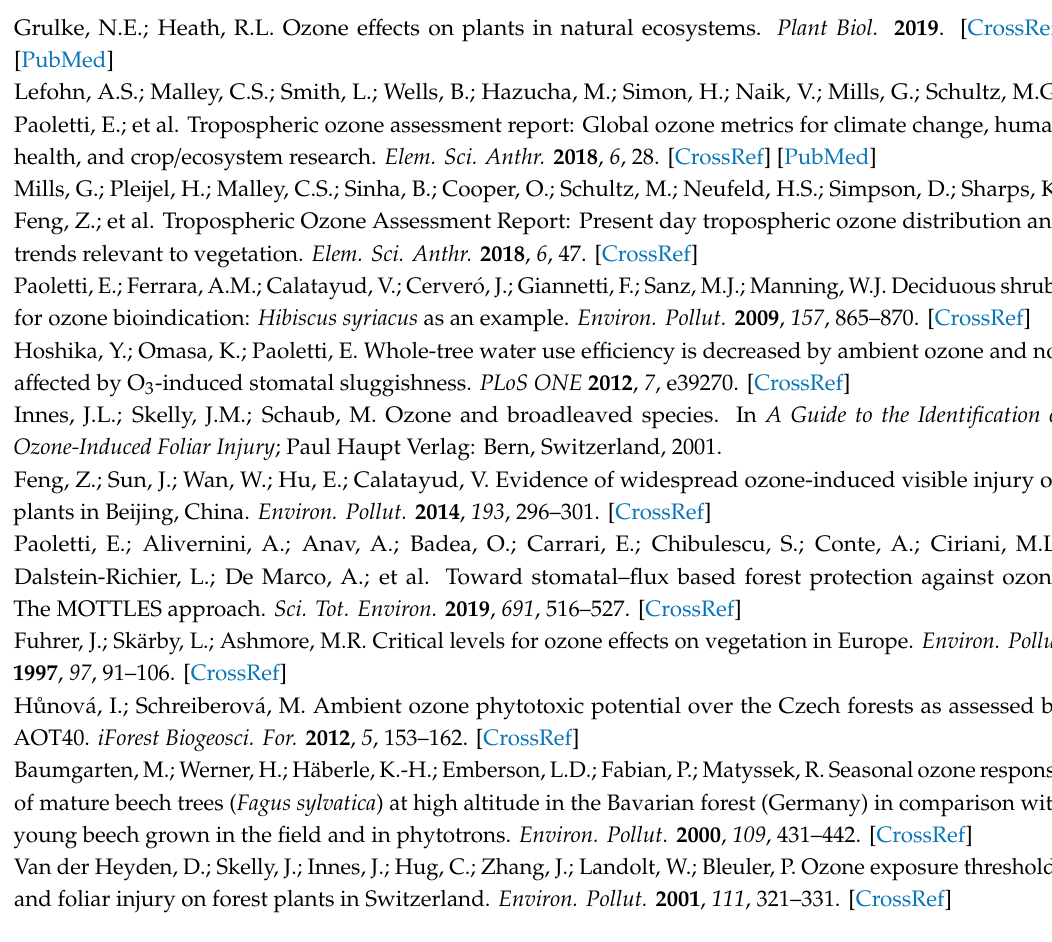
Figure S1: Comparison between measured and estimated g s in Alnus glutinosa , Sorbus aucuparia and Vaccinium myrtillus . Table S1: Summary for R 2 and the information of confidential interval (C.I.) in exposure or flux-based dose-response functions for plant injury index